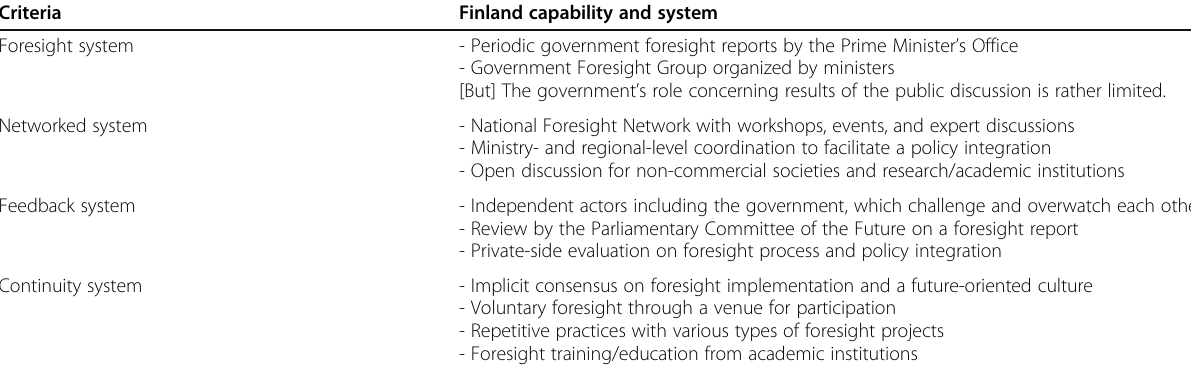
Table 3 Finland ’ s AG level under the new framework Criteria Finland capability and